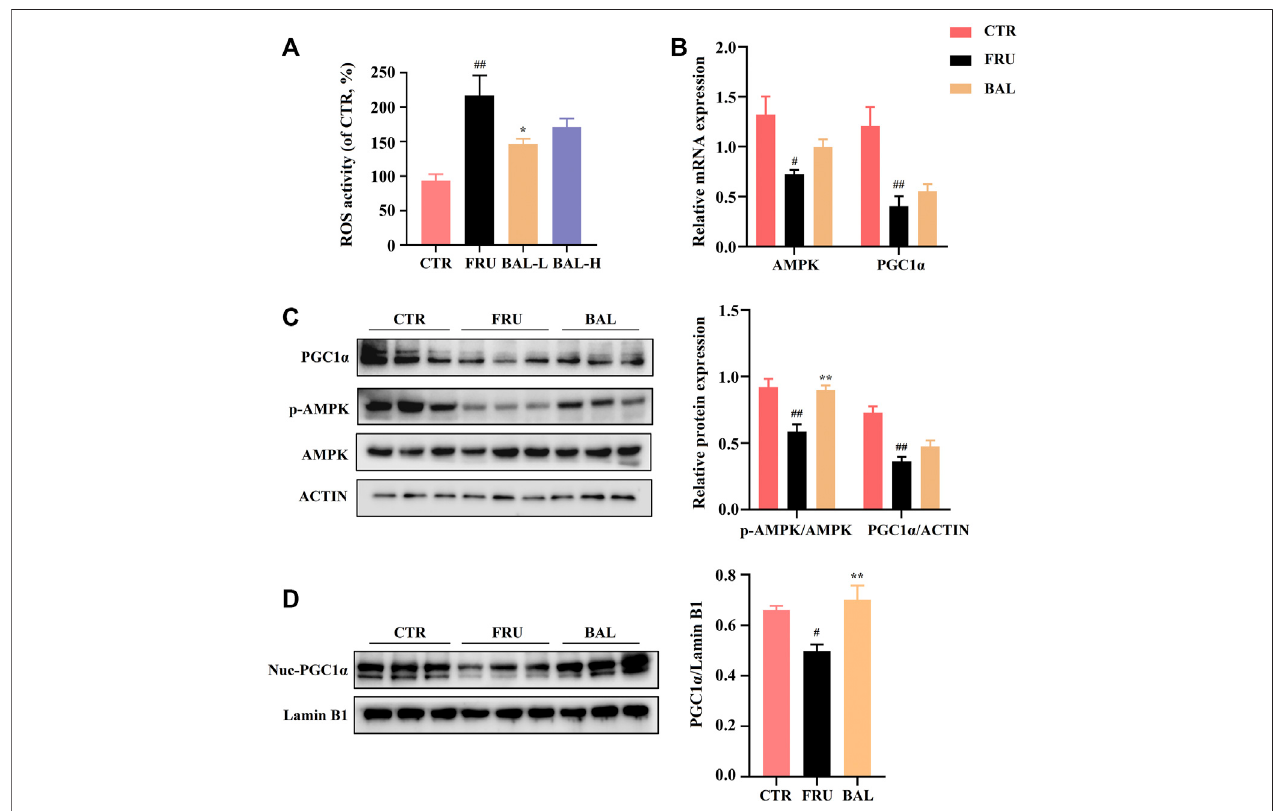
FIGURE7| Effectsofhepatic ROSandAMPK-PGC1 α pathway byBALtreatmentinfructose-fed rat liver. (A) ROSactivity inratliver. (B) mRNAlevel ofAMPKand PGC1 α . (C) PGC1 α expression andAMPKphosphorylationlevel (Thr172). (D) Thenuclearexpression ofPGC1 α .DatawererepresentedasMean±SEM( n =6/group), ## p < 0.01 , # p < 0.05 , compared with CTR; **p < 0.01 , *p < 0.05 , compared to